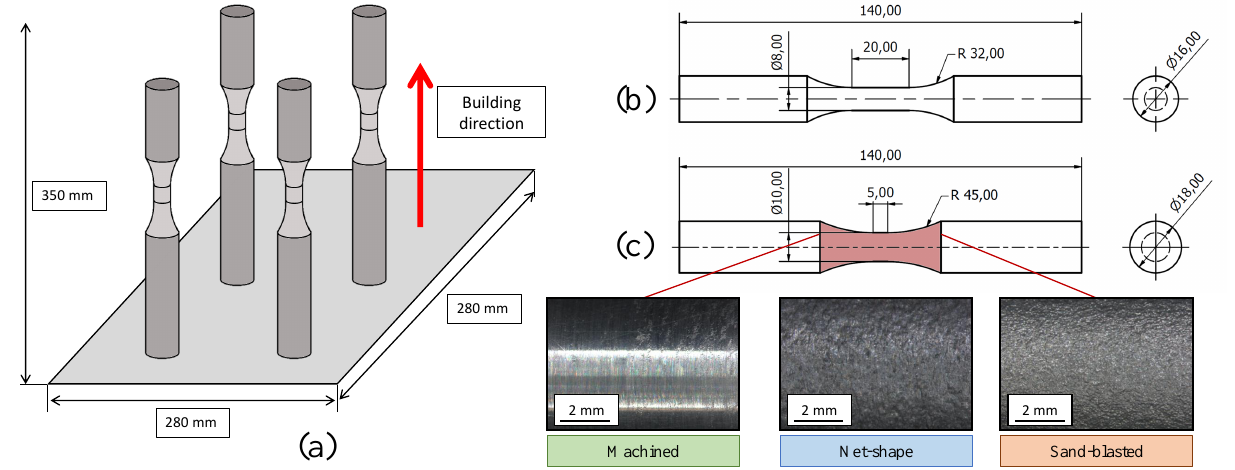
Figure 1. Printed specimens for the experimental campaign: ( a ) printing direction; ( b ) strain con- trolled fatigue tests’ specimen geometry according to the American Society for Testing Materials (ASTM) standard E606 [42] and ( c ) force control fatigue tests’ specimen geometry with a detail of the three different superficial conditions. All the dimensions are in mm.